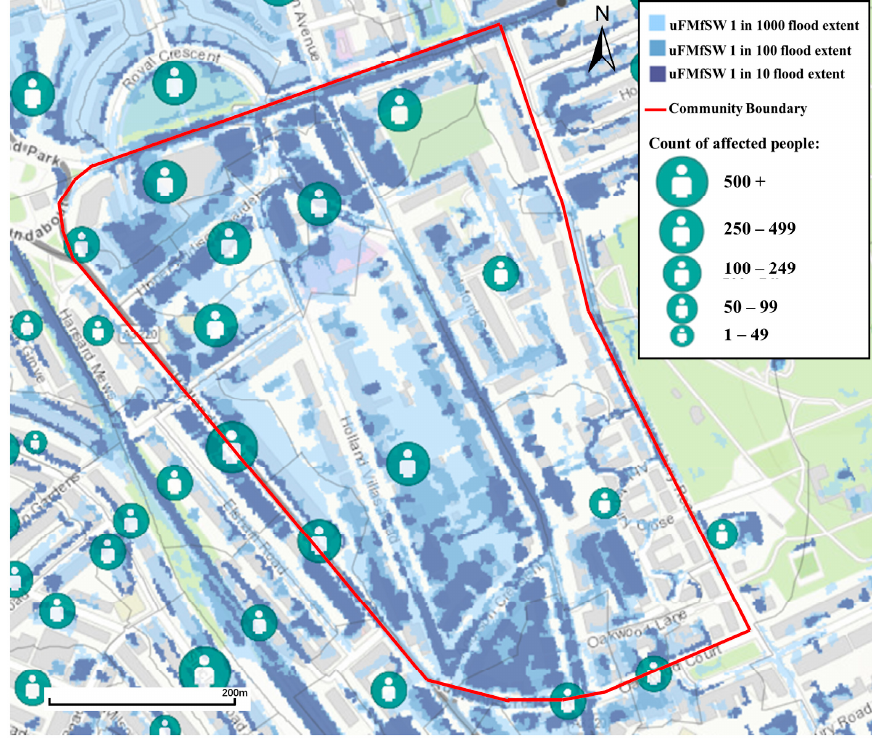
Figure 2. The flood risk map for surface water in the study area in RBKC, west London, England [56].